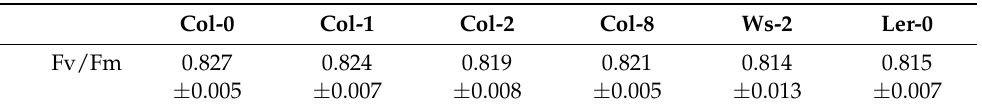
Figure A1. Quantitative analysis of selected photosynthetic complexes in thylakoids. ( A )—Relative optical density of bands corresponding to particular photosynthetic complexes separated via Native-PAGE electrophoresis for accession samples in respect to Col-1, ( B )—Visual panel for the B1–B6 symbolising specific complexes. Presented data are mean values ± SD from 3 independent experiments; pairs of results marked with an asterisk differ significantly at p = 0.05 (one-way ANOVA with the post hoc Tukey test). Table A1. The efficiency of PSII–Fv/Fm. Data are mean values ± SD from at least three independent